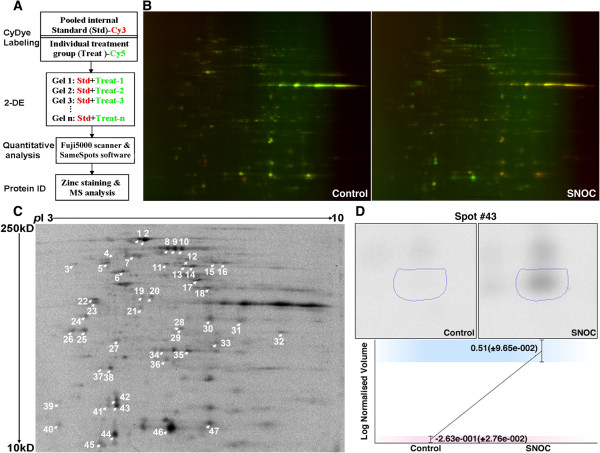
Identification and quantification of SNOC-induced protein S-nitrosylation in BV-2 cells by NitroDIGE. (A) Workflow of NitroDIGE to identify and quantify SNO-proteins. Pooled internal standard and individual samples are labeled with Cy3 and Cy5, respectively, and subjected to 2-DE. 2-DE gel fluorescence is detected using a Fuji 5000 scanner and quantified by the SameSpots software. On a corresponding zinc-staining gel, selected fluorescence intensity-differential spots are excised for MS analysis. (B) NitroDIGE analysis of protein S-nitrosylation in ex vivo SNOC-treated BV-2 cells. Following the work flow above, untreated control and SNOC-treated samples in biological triplicate were labeled with CyDye™ and resolved on six different gels. A representative gel from each group is shown. (C) Quantitative analysis with the SameSpots software revealed 47 spots with significant fluorescence intensity changes between SNOC-treated and untreated control samples (fold change >1.3, P <0.05). (D) Quantification results for spot #43 are displayed as an example.